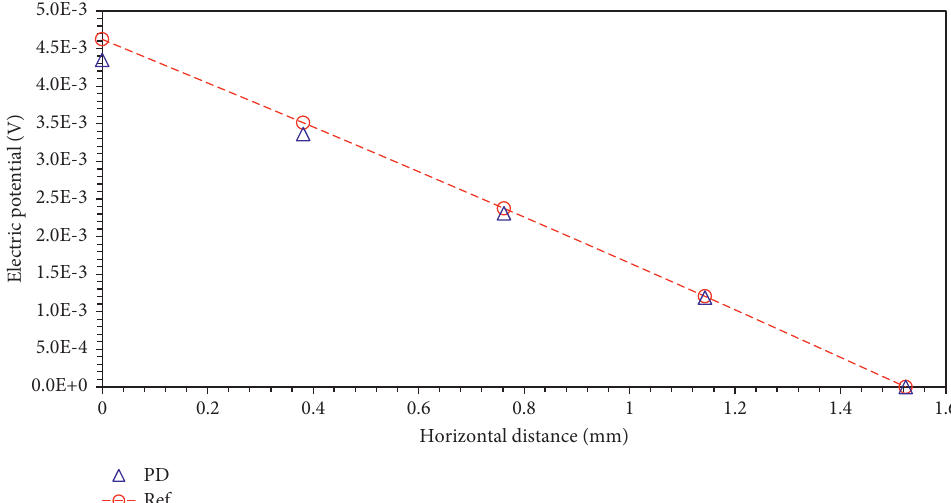
Figure 19: Comparison of potential values from PD and